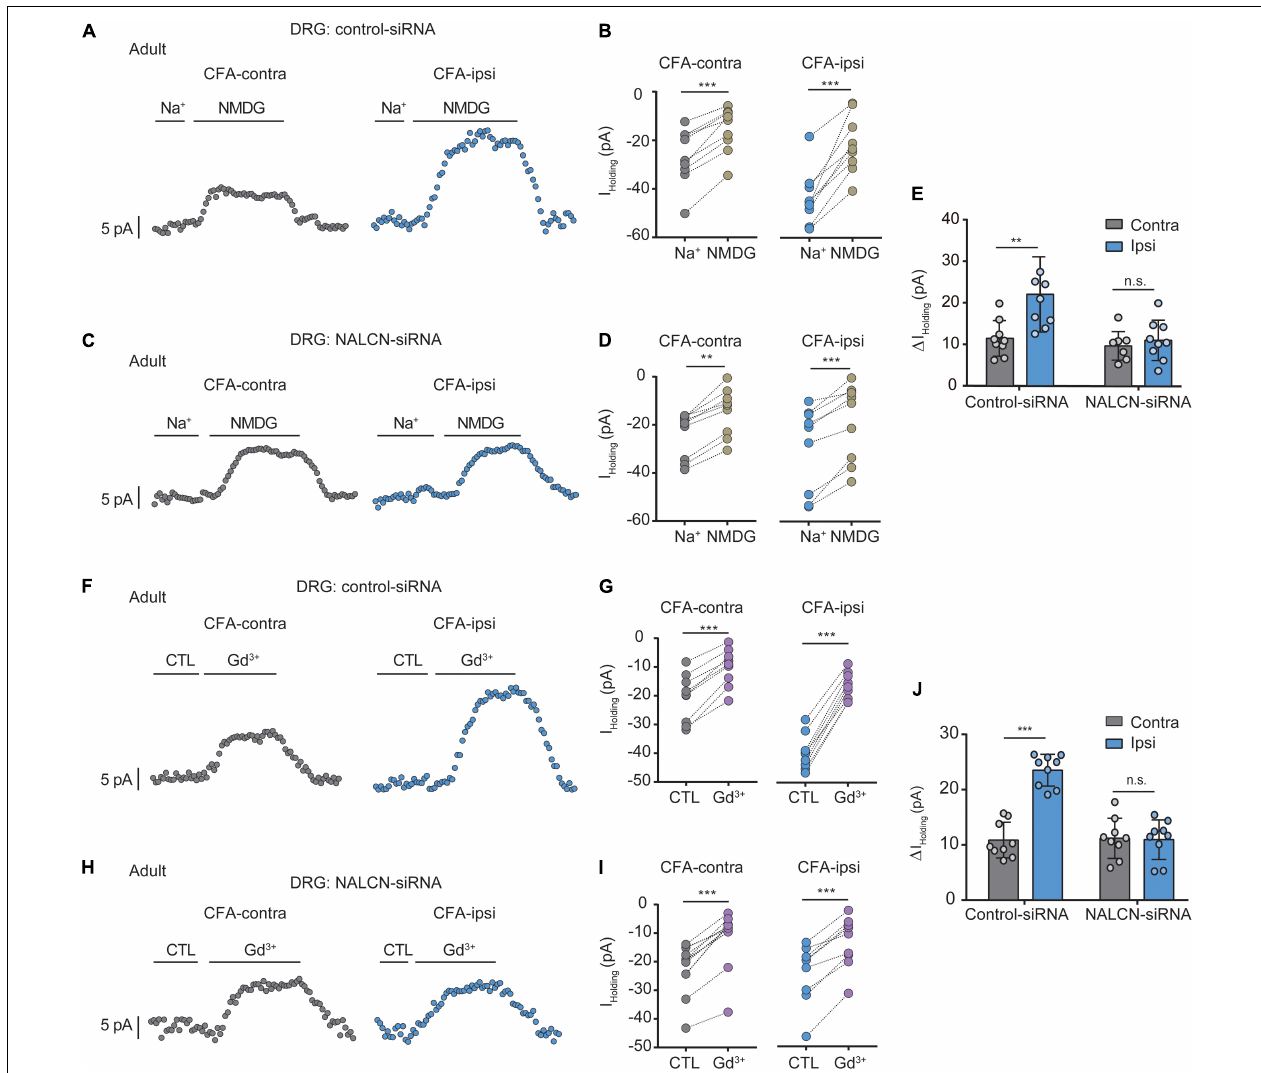
FIGURE 3 | Na + -mediated currents ( I holding ) and gadolinium (Gd 3 + )-inhibited I holding increase in small and medium neurons of DRG after injection of CFA in adult rats. Currents were recorded at holding potential of –60 mV. (A) Representative real-time analysis of I holding in small and medium DRG neurons from the rats that received control-siRNA combined with injection of CFA. I holding was extracted by replacing extracellular Na + with NMDG. (B) The I holding in small and medium DRG neurons of control siRNA-treated rats were analyzed before and after replacement with NMDG. (C) Representative real-time analysis of holding currents in small and medium DRG neurons from the rats that received NALCN-siRNA combined with injection of CFA. I holding was extracted by replacing extracellular Na + with NMDG. (D) The I holding in small and medium DRG neurons of NALCN siRNA-treated rats were analyzed before and after replacement with NMDG. (E) The I holding increased more in the DRG neurons of CFA-ipsi side than those of CFA-contra side from the control-siRNA-treated rats; treatment of NALCN-siRNA diminished the difference in I holding between CFA-ipsi and CFA-contra sides ( n = 9, by two-way ANOVA, Holm–Sidak test). (F) Representative real-time analysis of Gd 3 + -inhibited I holding in small and medium DRG neurons from the rats that received control-siRNA combined with injection of CFA. (G) The I holding in small and medium DRG neurons of control siRNA-treated rats was analyzed before and after perfusion of Gd 3 + . (H) Representative real-time analysis of Gd 3 + -inhibited I holding in small and medium DRG neurons from the rats that received NALCN-siRNA combined with injection of CFA. (I) The I holding in small and medium DRG neurons of NALCN siRNA-treated rats was analyzed before and after perfusion of Gd 3 + . (J) Gd 3 + -inhibited I holding increased more in the DRG neurons of CFA-ipsi side than those of CFA-contra side from the control-siRNA-treated rats; treatment of NALCN-siRNA diminished the difference in Gd 3 + -inhibited I holding between CFA-ipsi and CFA-contra sides ( n = 9, by two-way ANOVA, Holm–Sidak test). CFA-contra: CFA-contralateral side; CFA-ipsi: CFA-ipsilateral side; CTL: control, before perfusion of Gd 3 + ; DRG: dorsal root ganglion. Data are present as mean ± SD. ** p < 0.01, *** p < 0.001, n.s.: no significance.